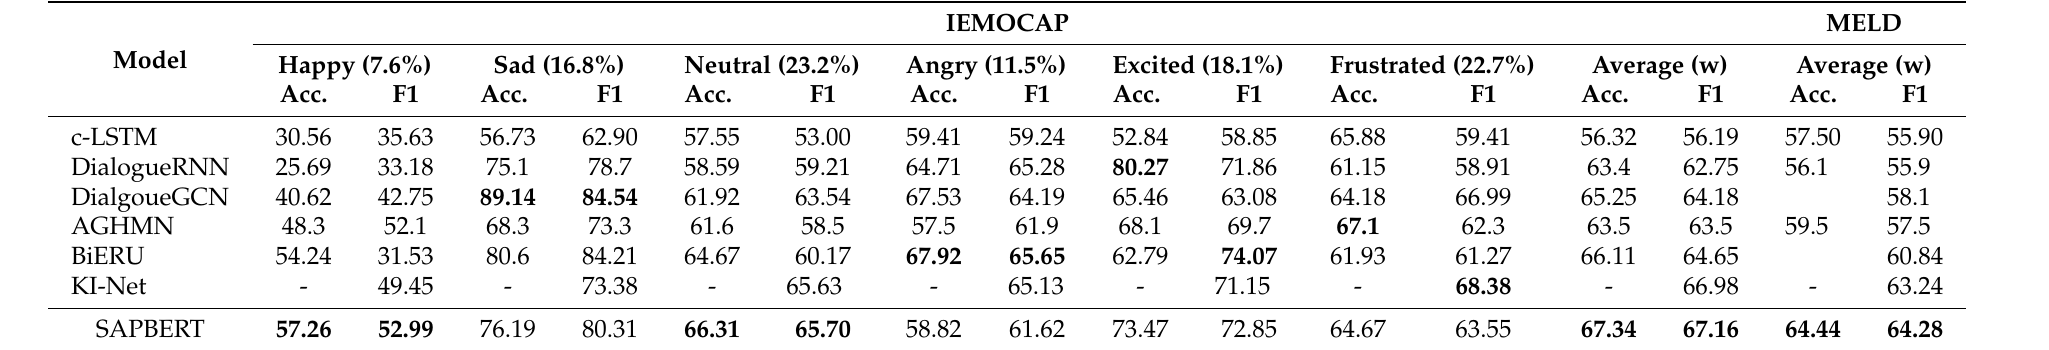
Table 4. Categorized ERC results of the IEMOCAP and the MELD dataset; The percentage beside the category means the percentage of each category of